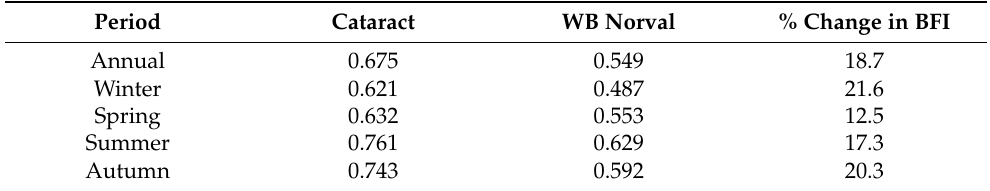
Table 8. Summary of the seasonal and annual baseflow index (rural and urban) for the period 1971–2019.